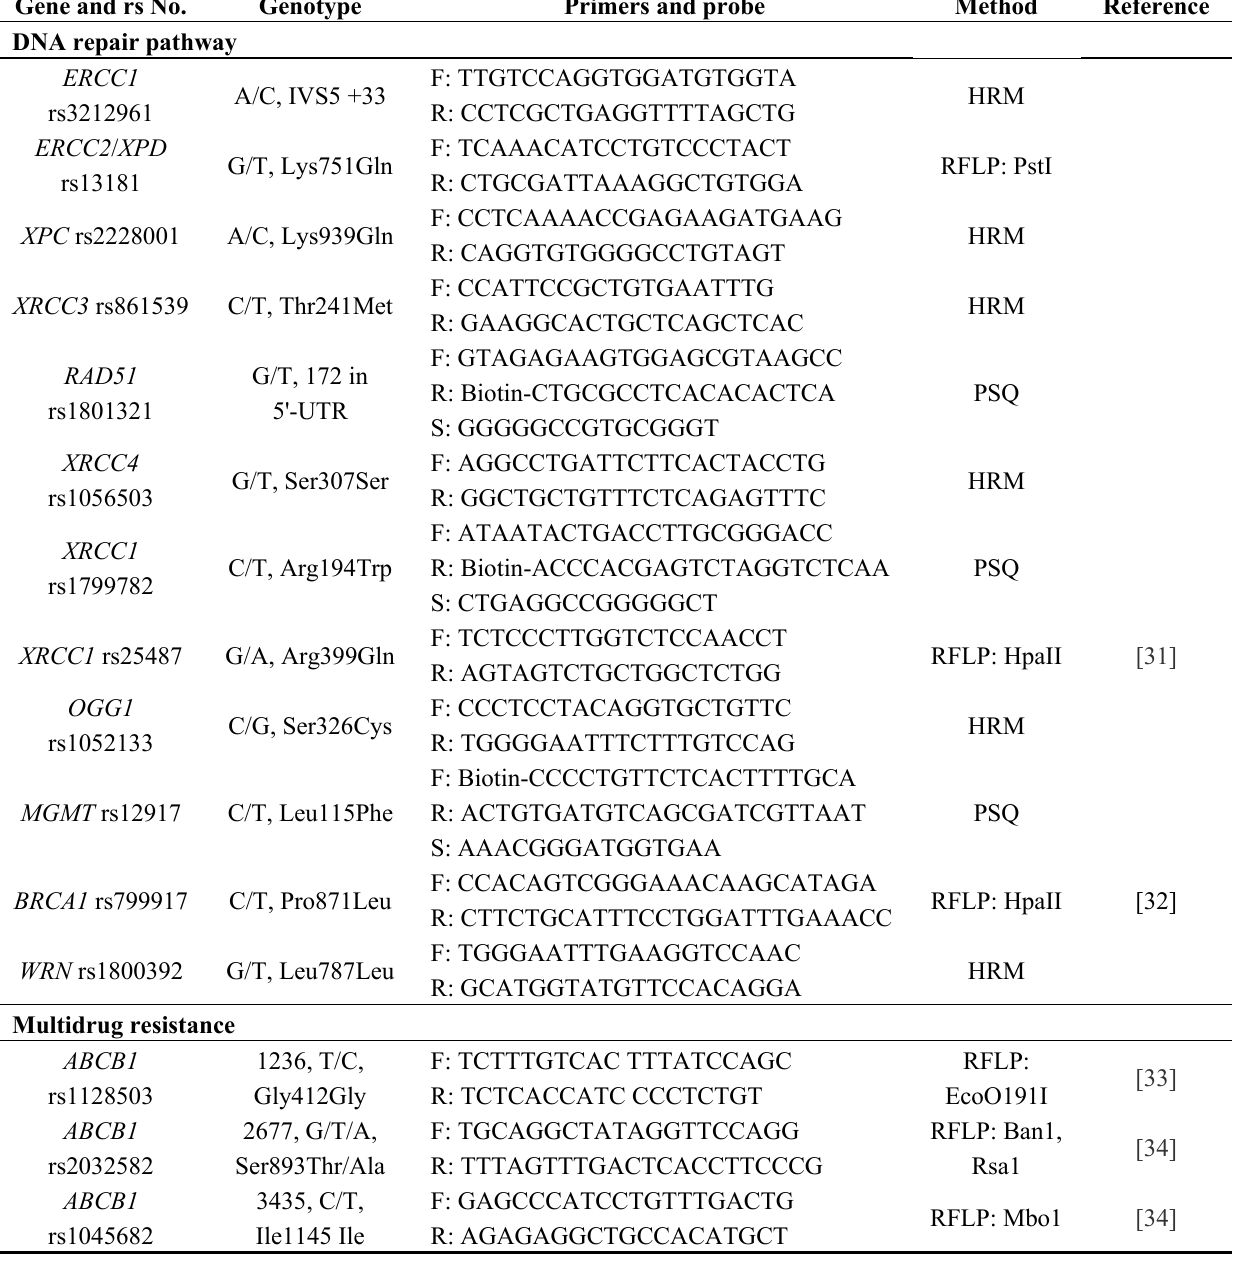
Table 1. Primer sequences and genotyping